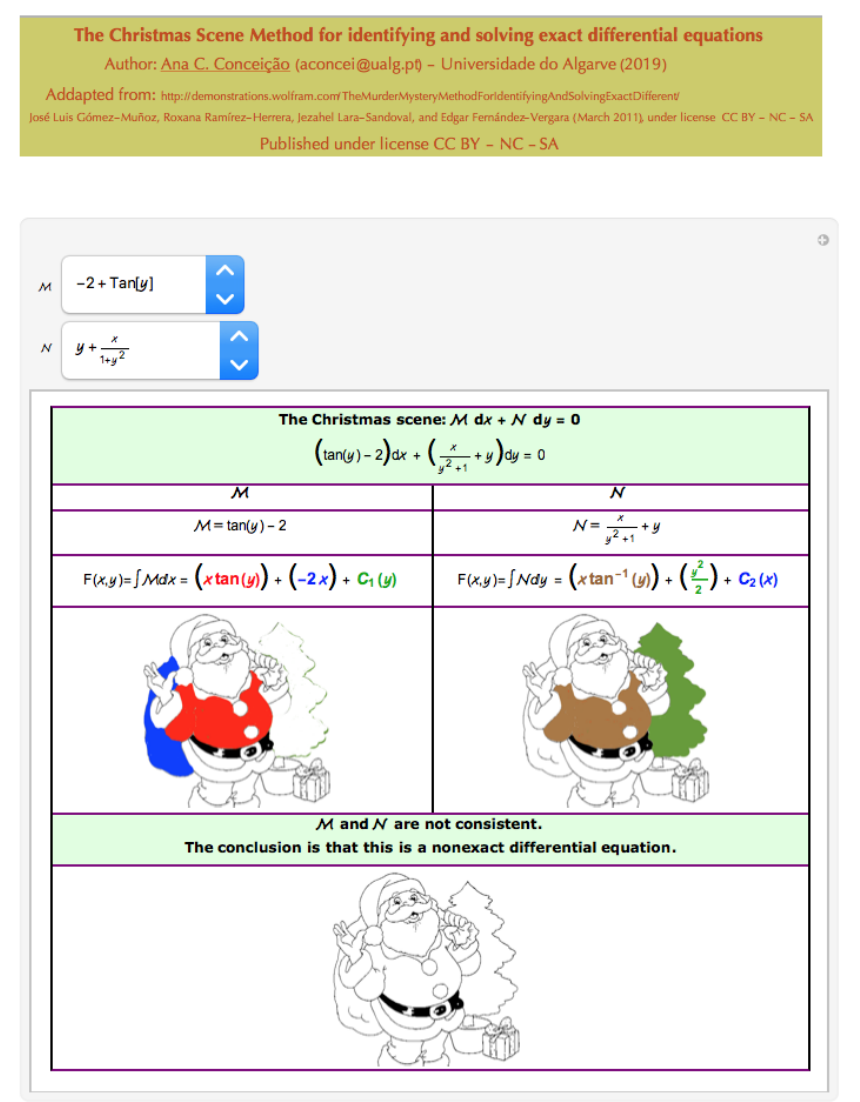
Figure 17. Image that illustrate an activity to be done in autonomous students’ work. The student must justify why it is not an exact